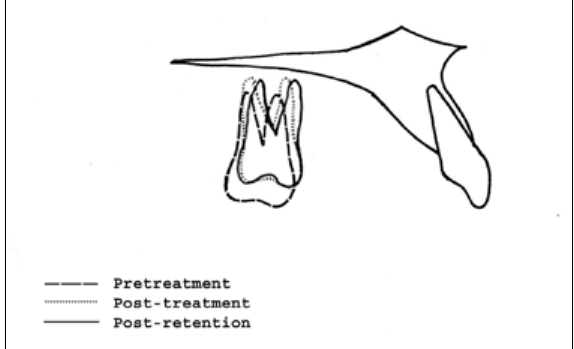
Figure 11. Superimposition showing maxillary molar